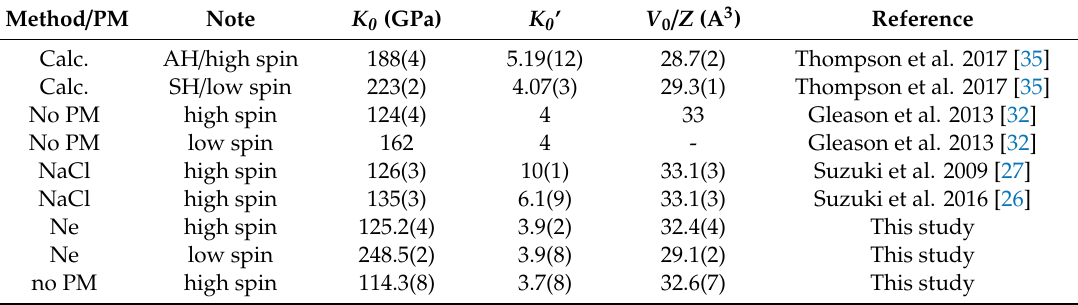
Table 2. Compressibility parameters of ε -FeOOH. Abbreviations: PM, Pressure medium.